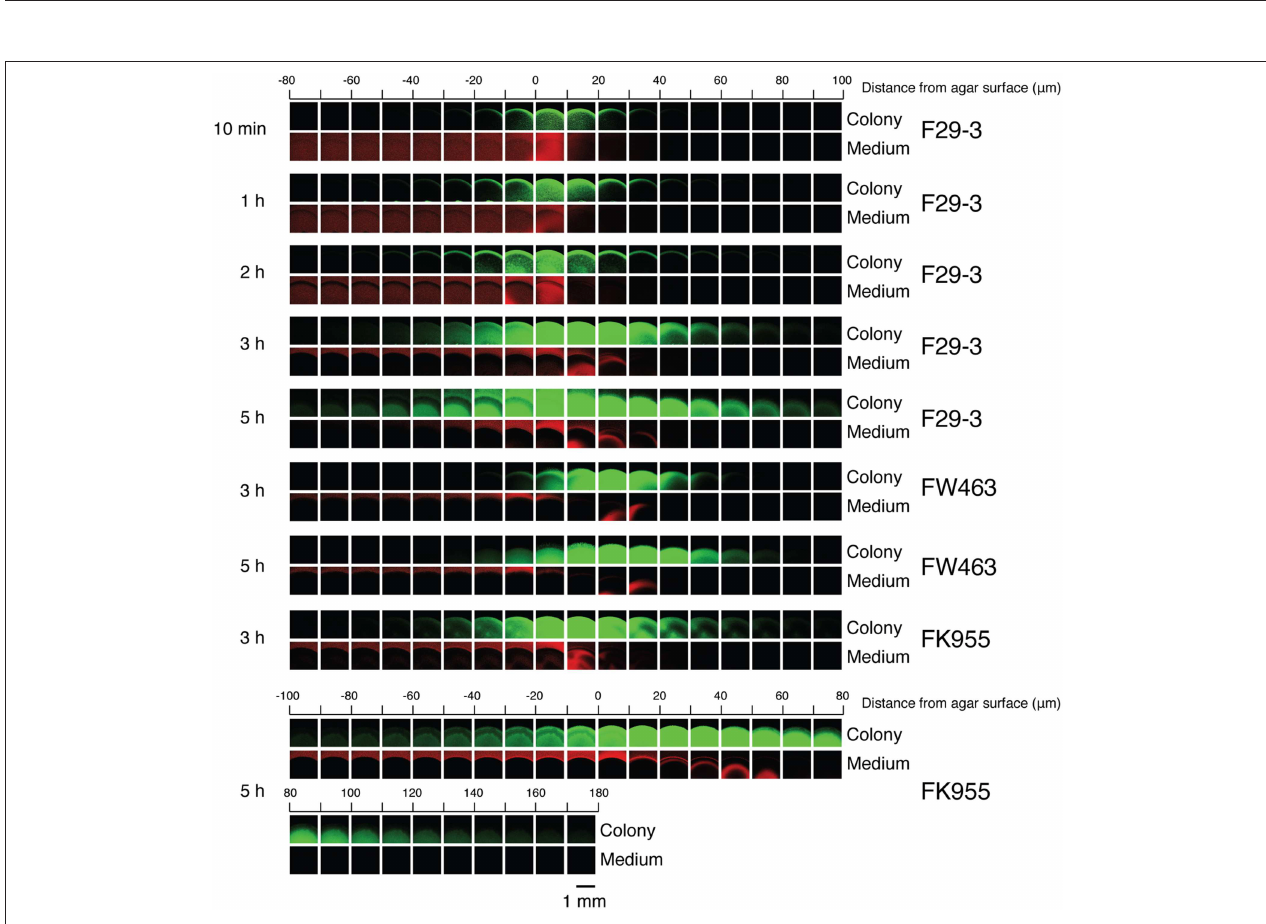
FIGURE 4 | Height and shape of colonies. Z stacks, with planes separated by 10 µ m, of colonies formed by B. subtilis F29-3(pHag-gfp), B. subtilis FW463(pHag-gfp) and B. subtilis FK955(pHag-gfp) were acquired using a confocal laser-scanning microscope. Bacteria were cultured on 8.5-ml LB-0.4 agar plates containing red carboxylate-modified FluoSpheres beads (Invitrogen). The last plane with red fluorescence outside the green colony area indicates the agar surface.